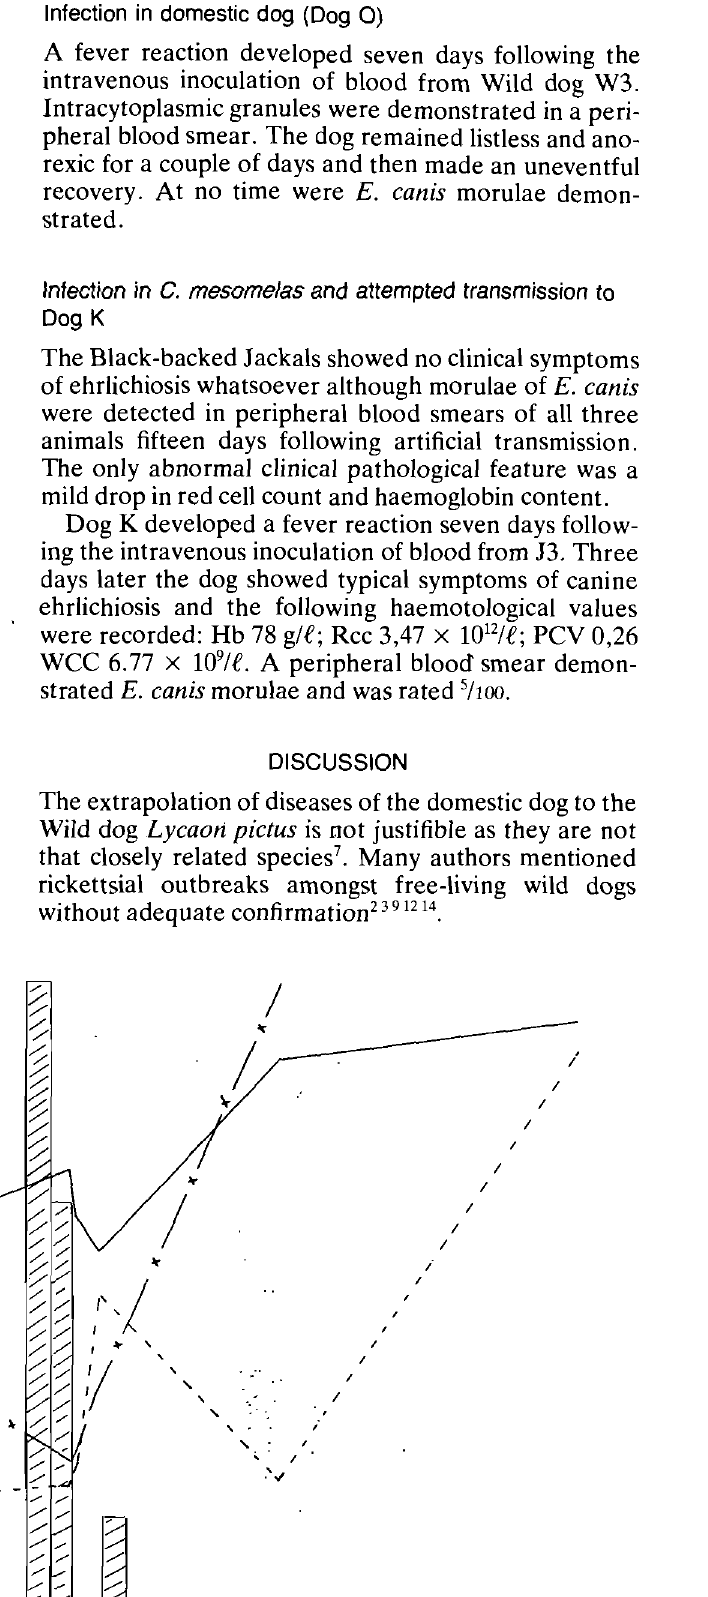
Table 2: HAEMATOLOGICAL VALUES FOR WILD DOGS OBTAINED ON DAY 0 Wild dog number